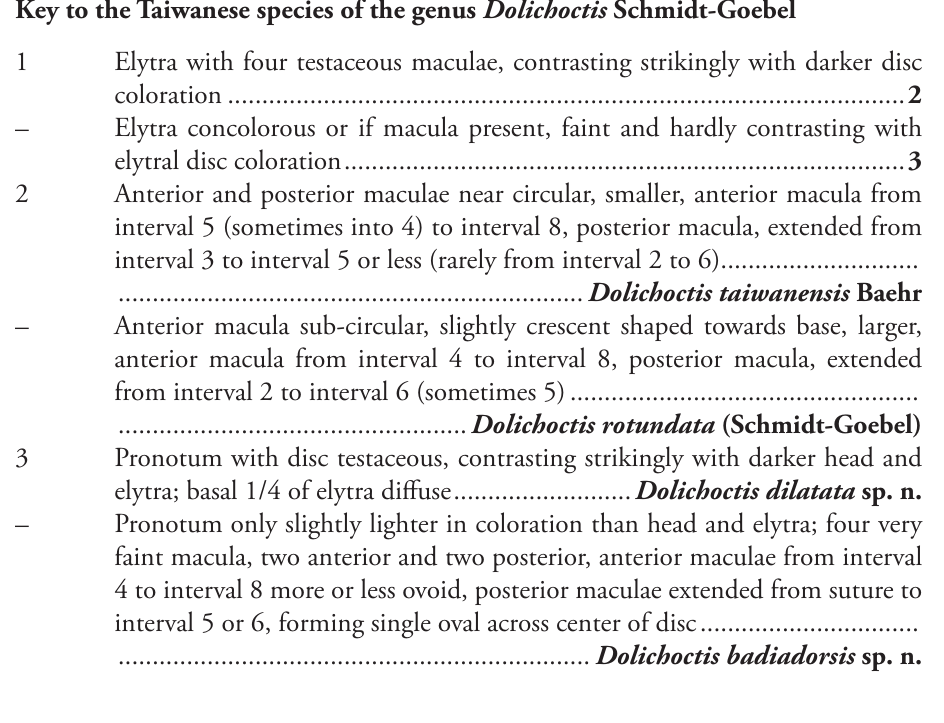
Dolichoctis badiadorsis sp.